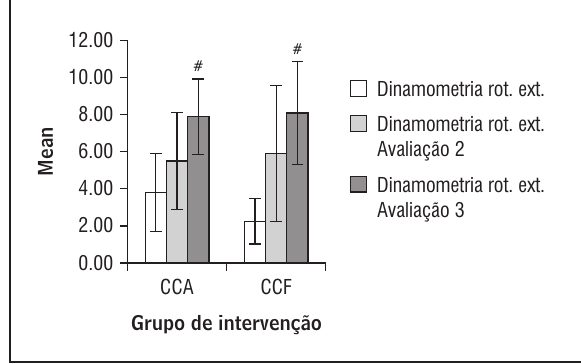
Figura 4 - Análise da força dinamométrica de rotação exter- na do ombro (kg) Legenda: # p = 0,001grupo CCF e p = 0,028 grupo CCA avaliação inicial para avaliação fi nal.